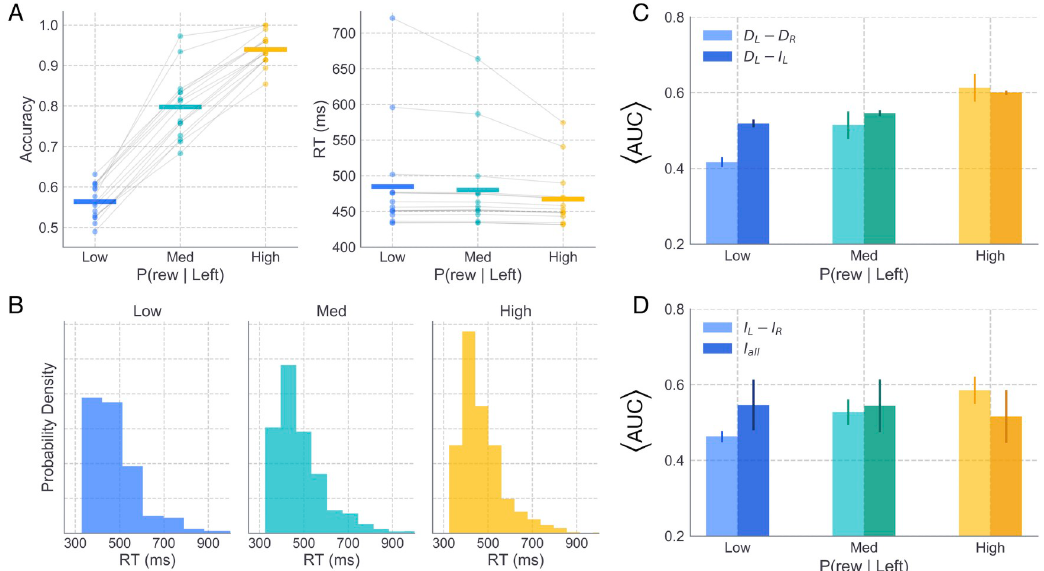
Fig 6. Simulated behavior and striatal influences from randomly sampled networks. A. Horizontal lines show subject-averaged accuracy (left) and correct response RT (right) means. Individual subject means are displayed as dots, connected by lines across conditions. B. Correct RT distributions in low (blue), medium (cyan), and high (yellow) reward conditions. C-D. Normalized striatal regressors, as in Fig 4C and 4D.